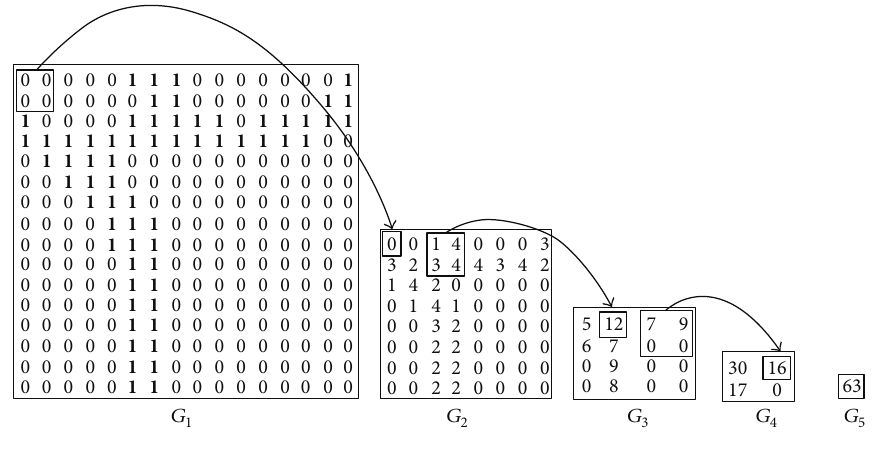
Figure 3: Mapping of a 16 × 16 image into a vector.